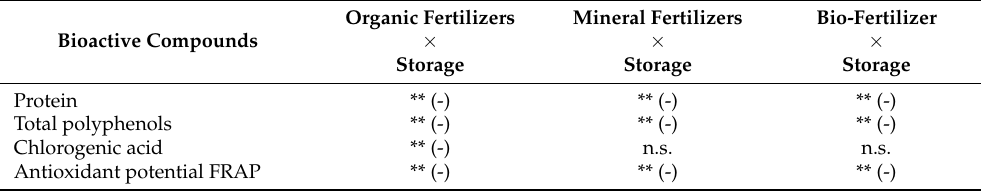
Table 3. Effect of organic and mineral fertilization, bio-fertilizers, and storage on the bioactive